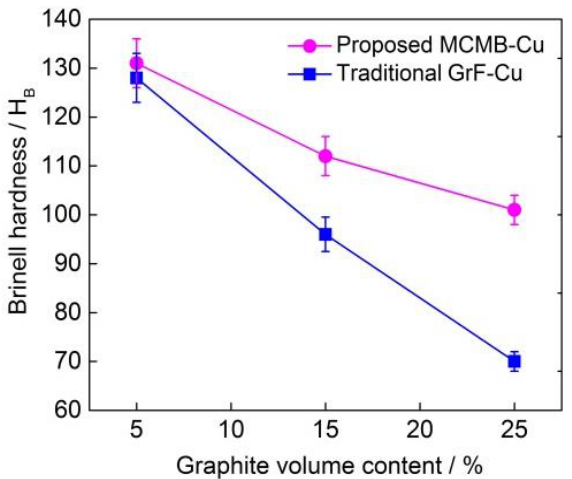
Figure 6. Brinell hardness value of the MCMB–Cu and GrF–Cu composites with different MCMB and GrF volume contents.